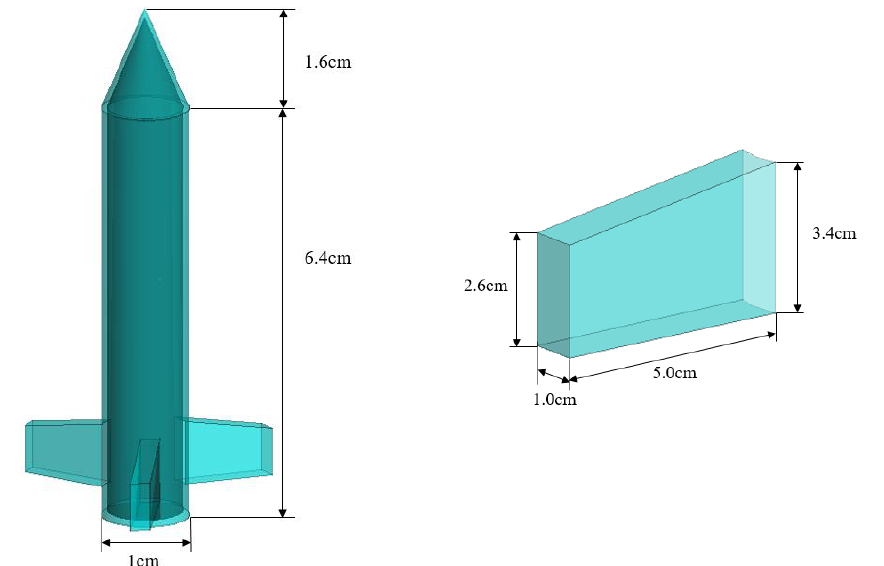
Figure 13. The posture of the coated missile based on satellite-borne illuminator.